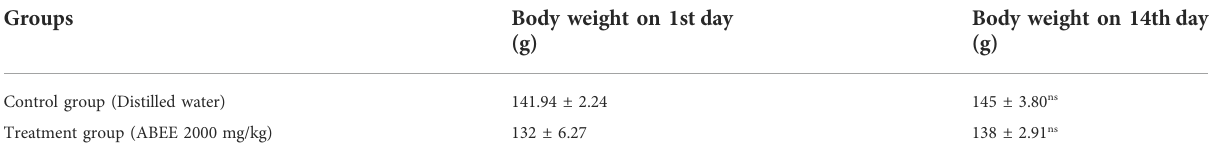
TABLE 1 Effect of ABEE (at limit dose 2000 mg/kg p.o.) and vehicle treatment on body weight of rats in acute toxicity study.